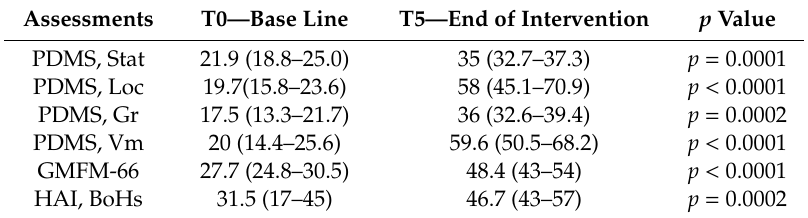
Table 2. Alterations (means and 25–75 percentile) in the scores on the Peabody Developmental Motor for Infants (HAI) after the end of intervention (T5) in comparison to the baseline (T0). Assessments T0—Base Line